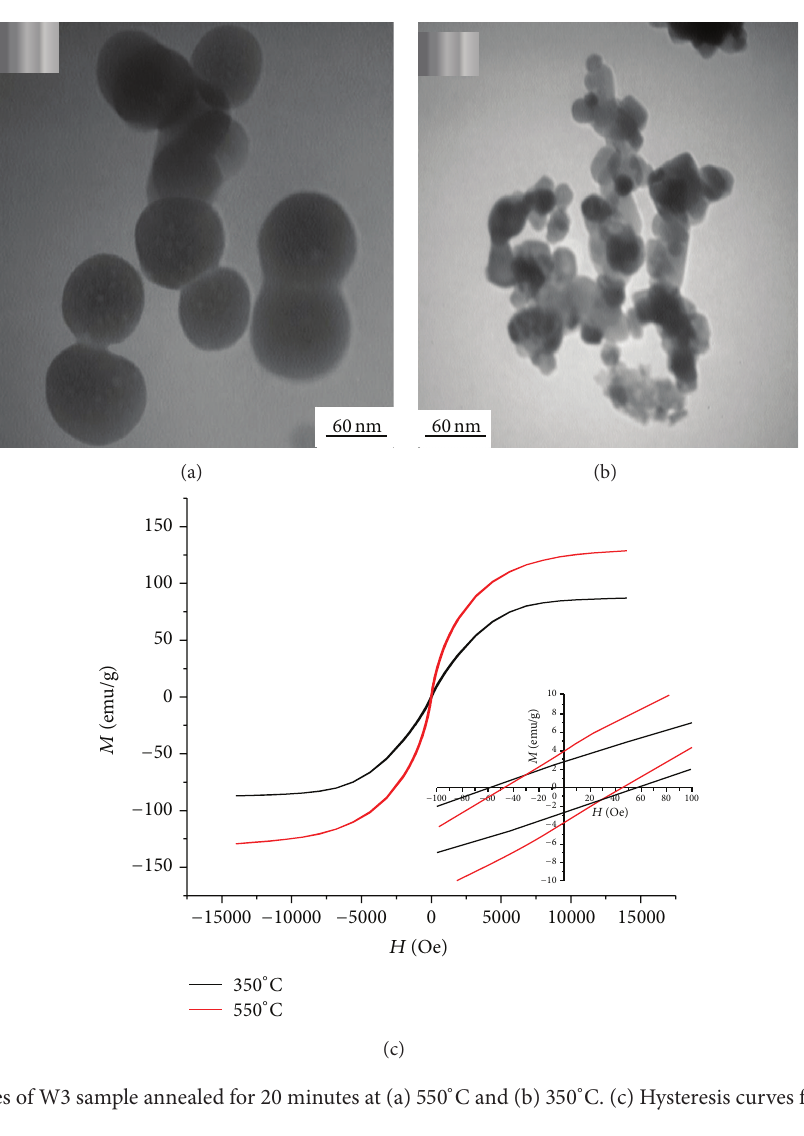
Figure 6: TEM images of W3 sample annealed for 20 minutes at (a) 550 ∘ C and (b) 350 ∘ C. (c) Hysteresis curves for annealed samples.